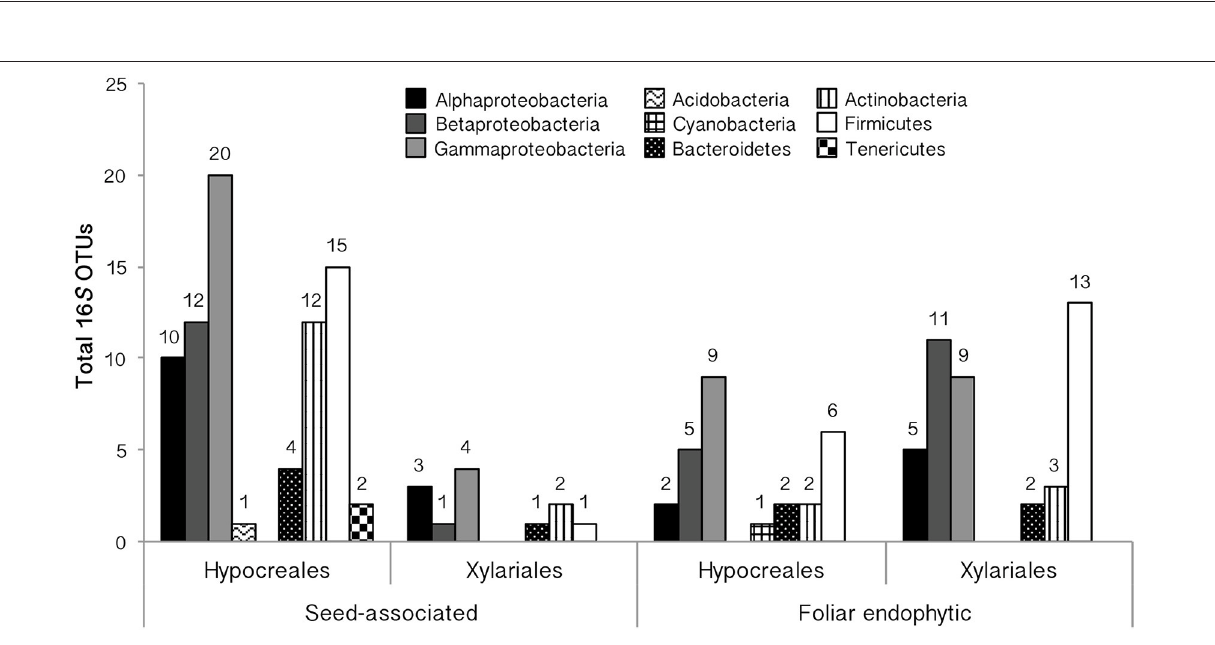
FIGURE 4 | Taxonomic placement of EHB among tropical seed-associated and foliar endophytic Hypocreales and Xylariales. EHB OTUs are organized by phylum (or by class for